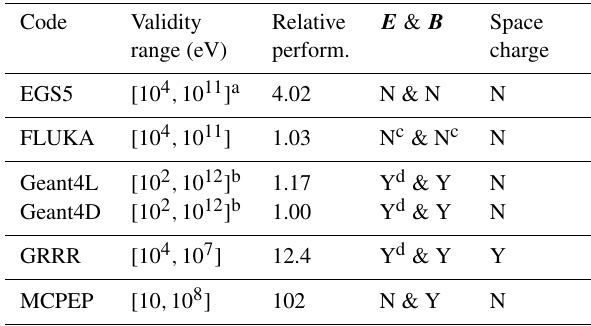
Table 1. Codes used in this benchmark, their validity range (us- able energy interval) and relative performance (normalized to the fastest code), possible inclusion of electric and magnetic fields ( E and B ) and self-consistent fields due to space charge. It should be noted that the synchronous particle tracking in GRRR, for the possi- ble inclusion electric fields due to space charge, and the simulation without low energy cutoff approximation in MCPEP, limits their performance. For more descriptions, see Sect.